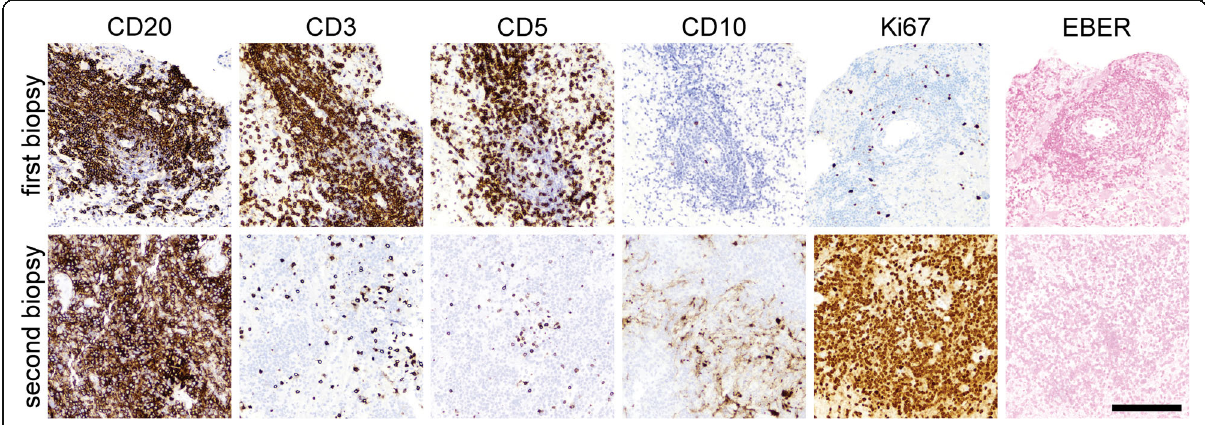
Fig. 3 Comparative immunohistochemistry between the first and second biopsies. See “ Case presentation ” section for description. Of note, the vessel shown in the CD20/3/5/10 panels from the first biopsy was adjacent to the vessel shown in the Ki67/EBER panels, due to the original vessel diminishing on deeper sectioning. Scale bar = 200 μ